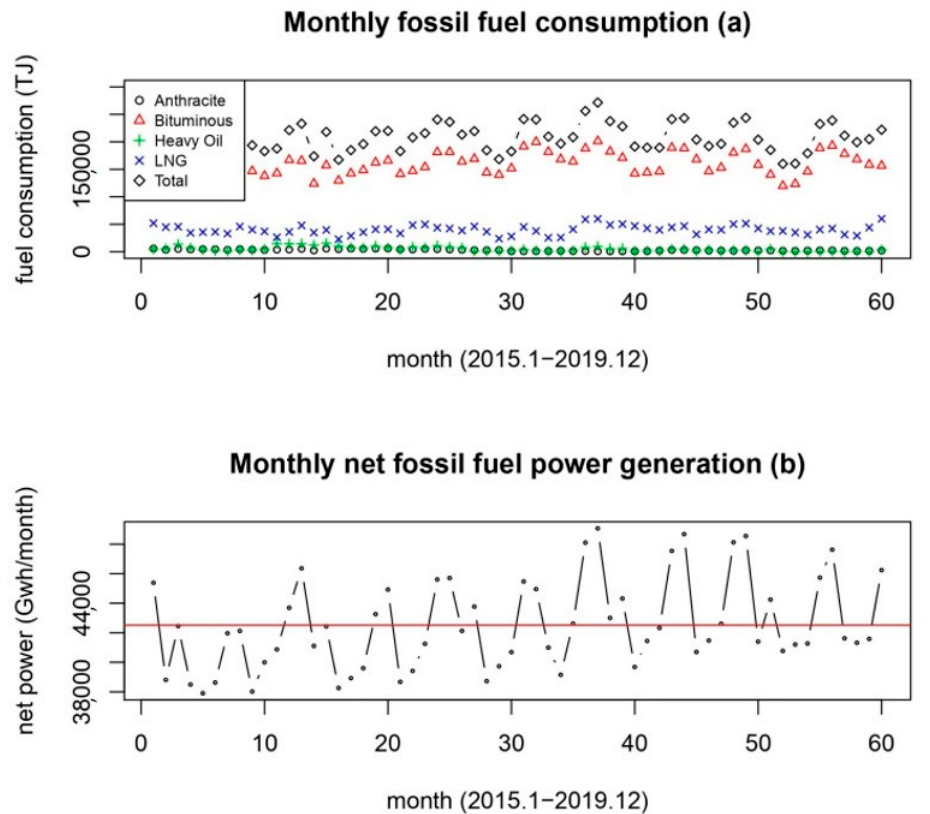
Figure 2. Monthly fossil fuel consumption ( a ) and monthly net fossil fuel power generation ( b ). The monthly electricity emission factors (average, minimum, and maximum) were plotted in Figure 3a. The three fuel emission factors (minimum, average, and maximum)